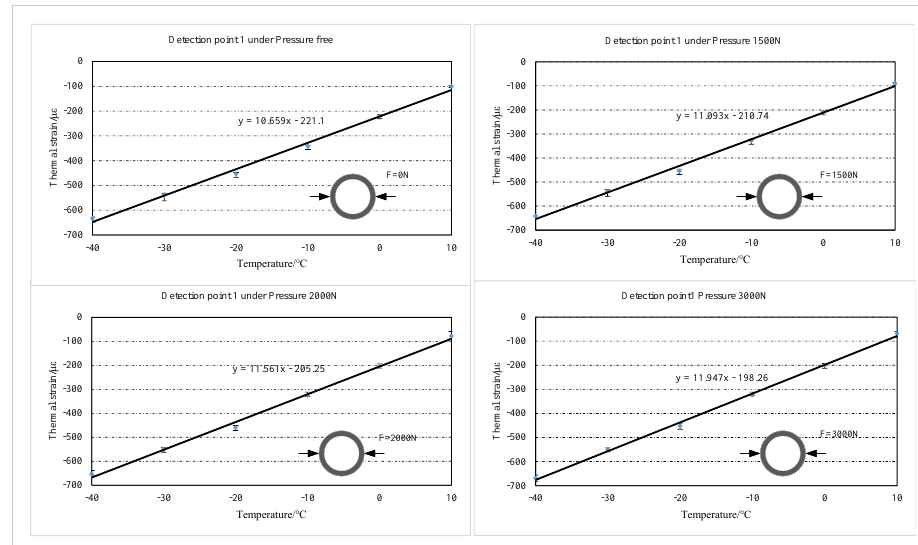
Figure 9. Error bar of the thermal strain in detection point 1 under each stress condition.